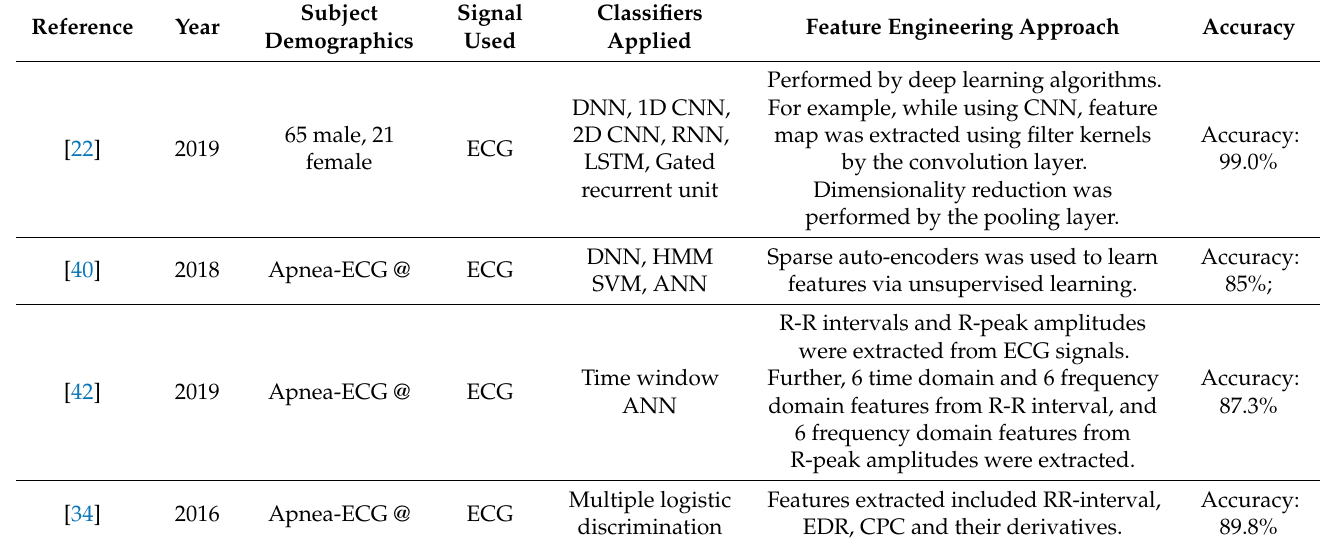
Table A1. Machine/deep learning based sleep apnea detection using biomedical